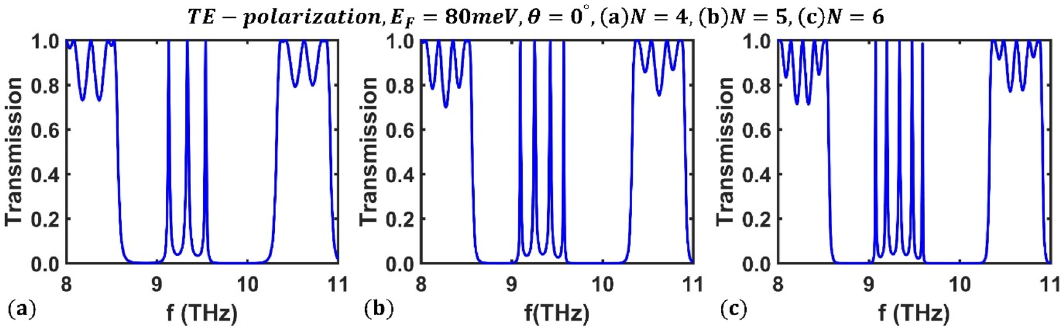
Figure 7. Transmission spectrum of the third-order F-1D PhC for TE polarization state under normal incidence corresponding to Fermi energy E F = 80 meV and period numbers ( a ) N = 4 periods, ( b ) N = 5 periods, and ( c ) N = 6